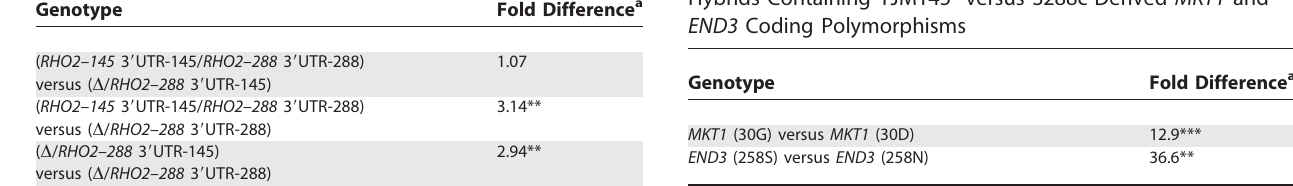
Table 5. Growth Difference at 41 8 C between YJM145/S288c Hybrids Containing YJM145- versus S288c-Derived MKT1